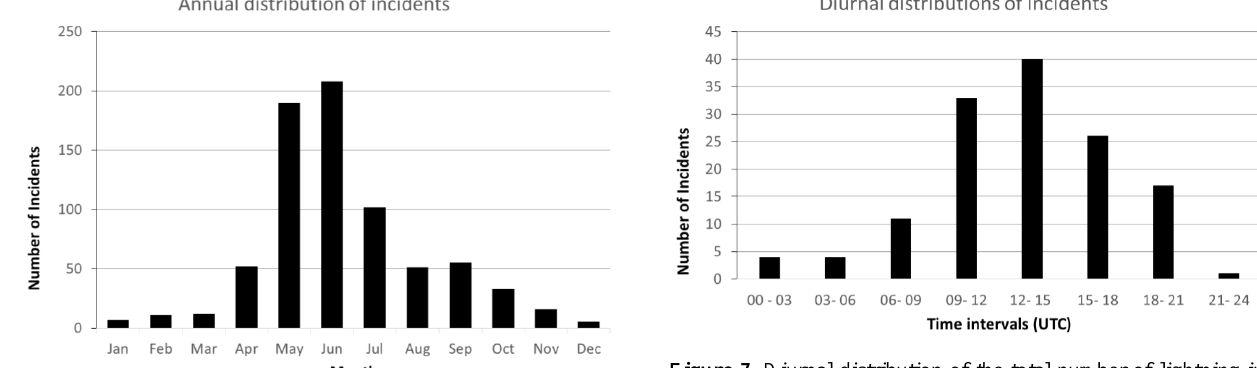
Figure 7. Diurnal distribution of the total number of lightning in- cidents by 3h period (January 1930 to June 2014). Local time in Turkey is UTC + 2 from October to March and UTC + 3 from April to September due to daylight saving